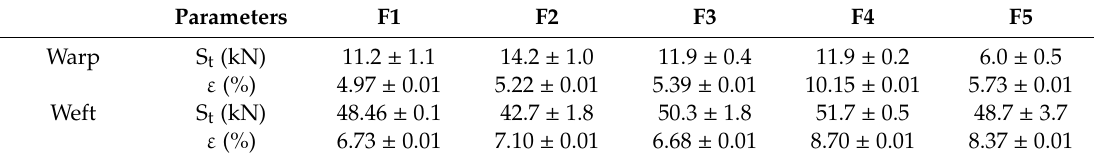
Table 5. Ultimate force (S t ) and failure value ( ε ) of fabrics in the warp direction and weft direction. Parameters